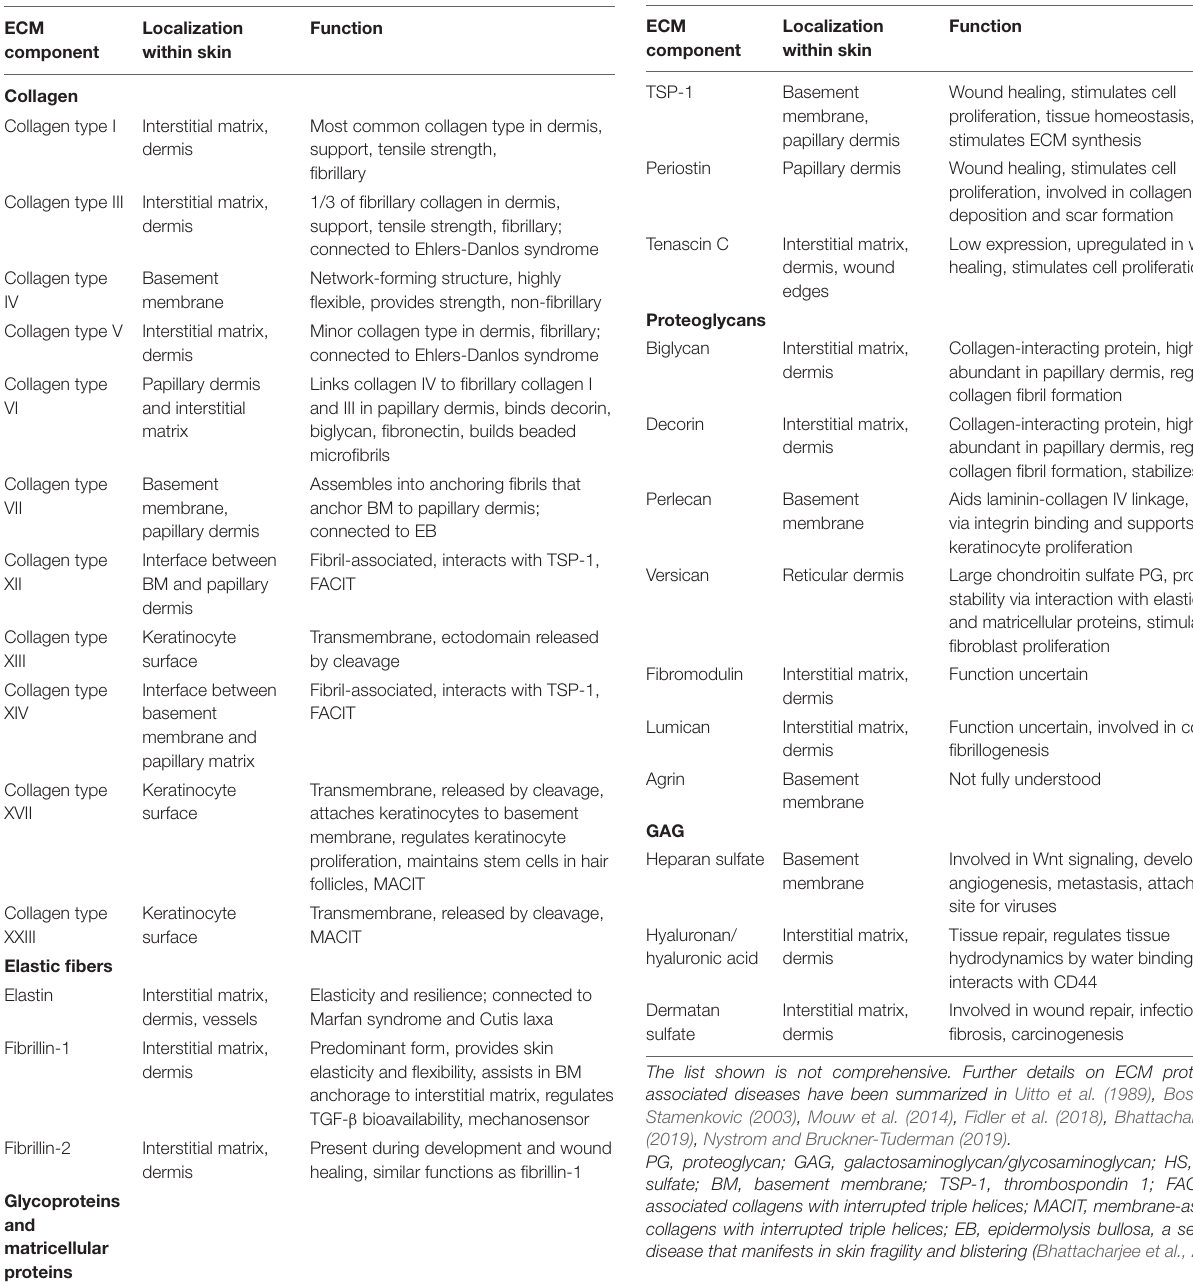
TABLE 1 | Core extracellular matrix components in human